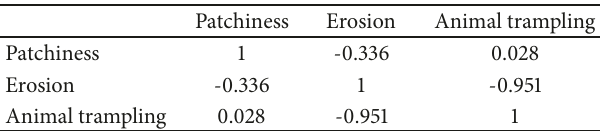
Table 6: Intercorrelations (Pearson) between the environmental variables (soil erosion, animal trampling, tree felling, bushfire, and patchiness) in bird dataset, during the wet season. A correlation above/below ± 0.61 is significant at p = 0.001 ∗∗∗ ; ± 0.45 at p = 0.01 ∗∗ and ± 0.33 at p = 0.05 ∗ . Patchiness Erosion Animal trampling Patchiness 1 -0.336 0.028 Erosion -0.336 1 -0.951 Animal trampling 0.028 -0.951